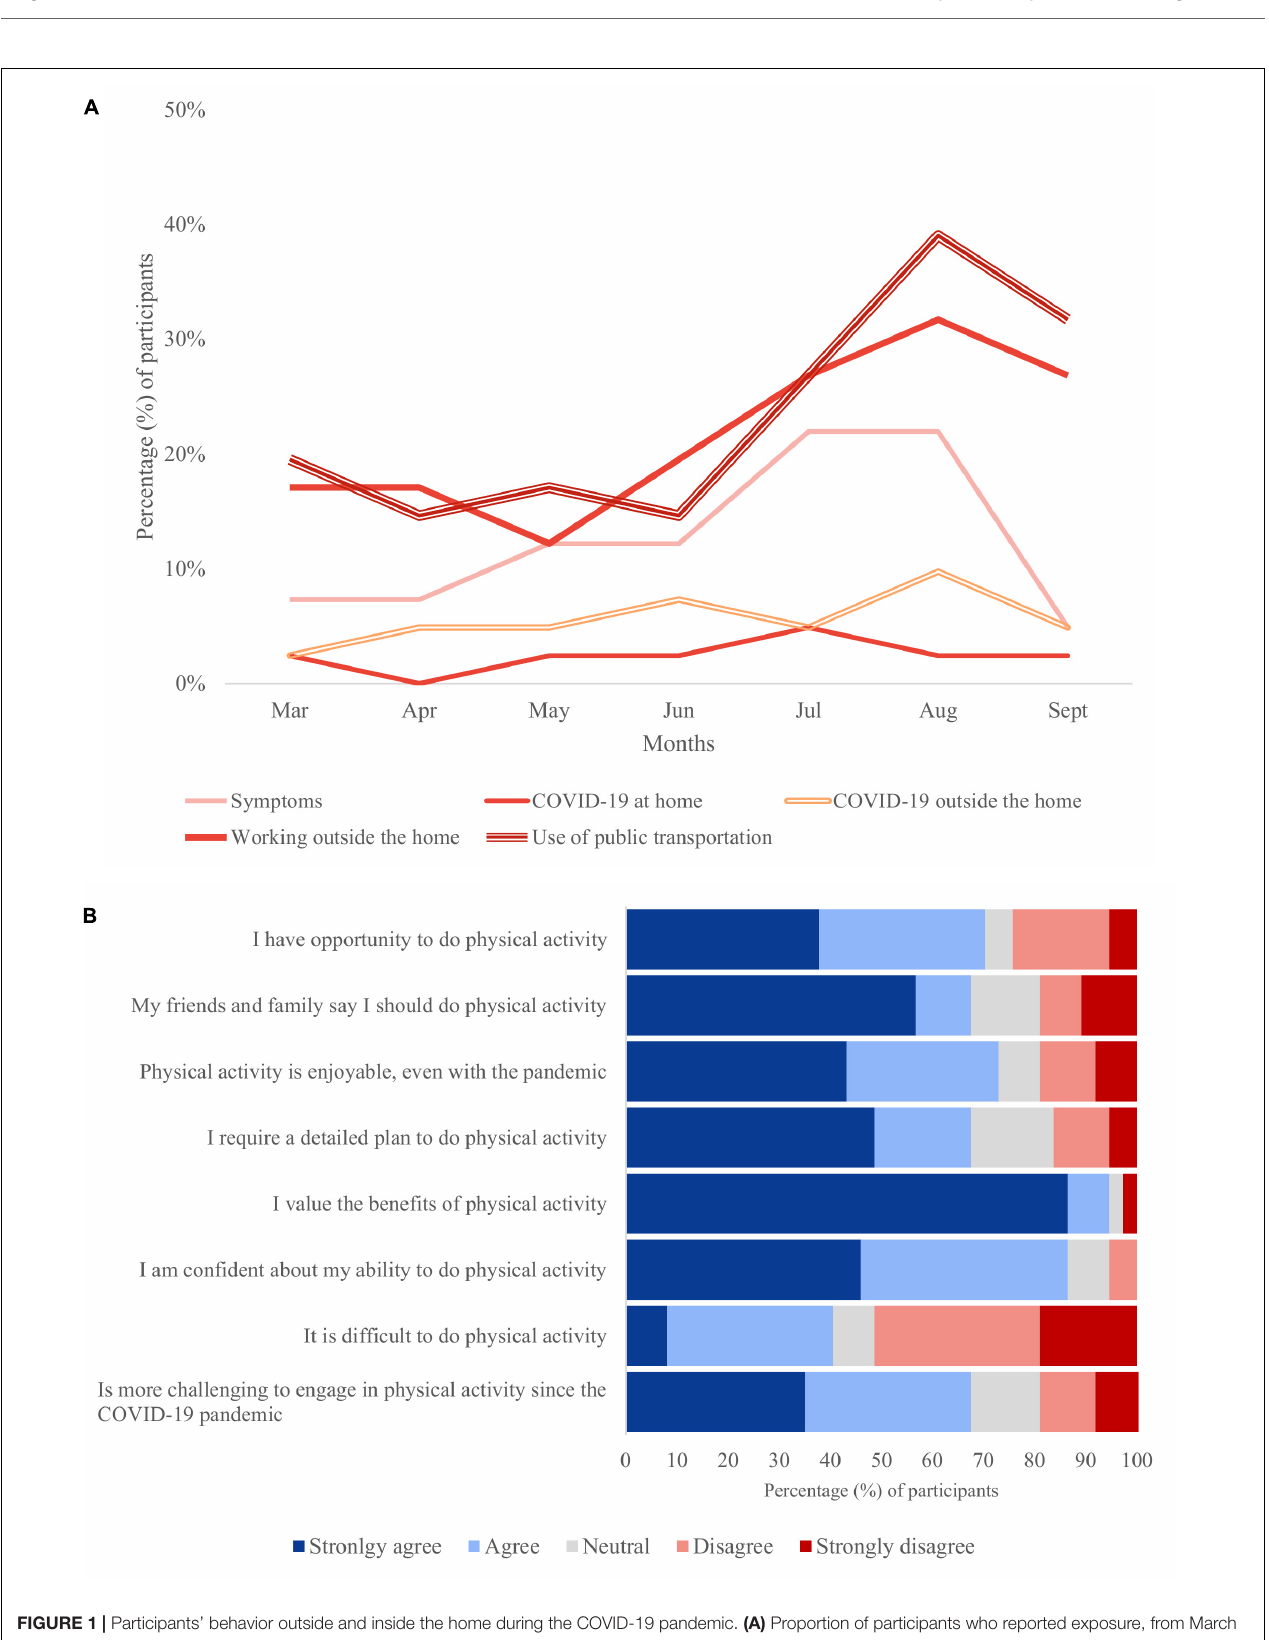
FIGURE 1 | Participants’ behavior outside and inside the home during the COVID-19 pandemic. (A) Proportion of participants who reported exposure, from March to September 2020, to suspected or confirmed cases of COVID-19 at home, outside the home, and who used public transportation ( n = 37). (B) Barriers and facilitators for physical activity perceived in September 2020 ( n = 37). Results are presented in percentage.